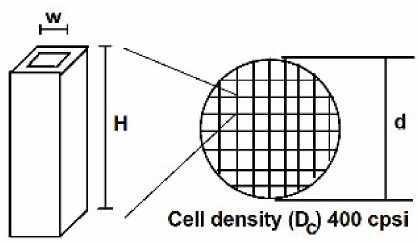
Figure 10. Schematic representation of a channel and monolith section seen from the